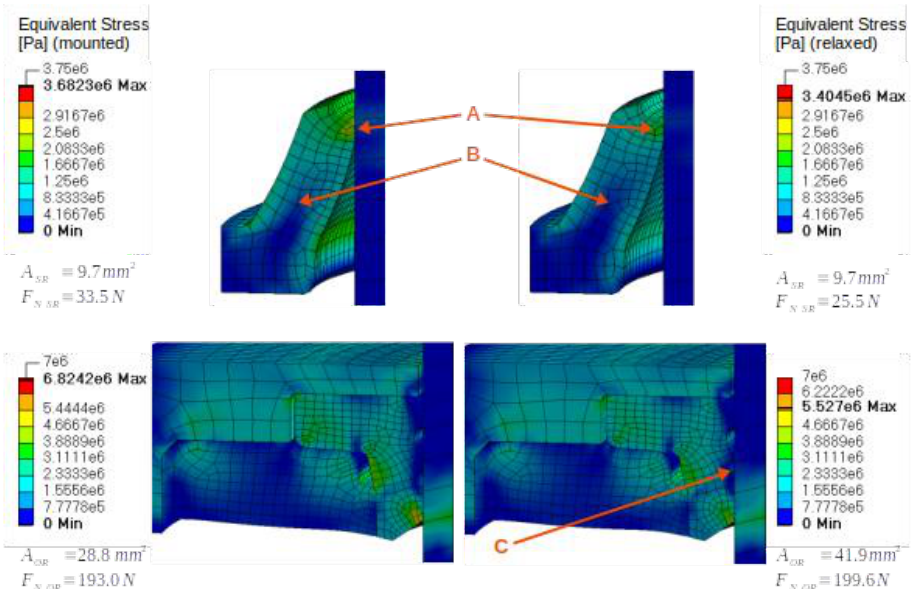
Figure 12. Comparison of the equivalent stress distribution of the target rod guide assembly/rod FEM setup, divided into the scraper/rod contact ( top ) and the oil seal/rod contact ( bottom ), before ( left ) and after ( right ) material relaxation time with the resulting contact areas 𝐴 𝑆𝑅 ; 𝐴 OR and the circumferential scraper/rod and oil seal/rod contact normal forces 𝐹 𝑁 𝑆𝑅 ; 𝐹 𝑁 OR . (A) showing decreasing maximum equivalent stress during relaxation; (B) showing increasing low-stress area during relaxation; (C) showing the center lip of the oil seal coming into contact with the rod during relaxation.